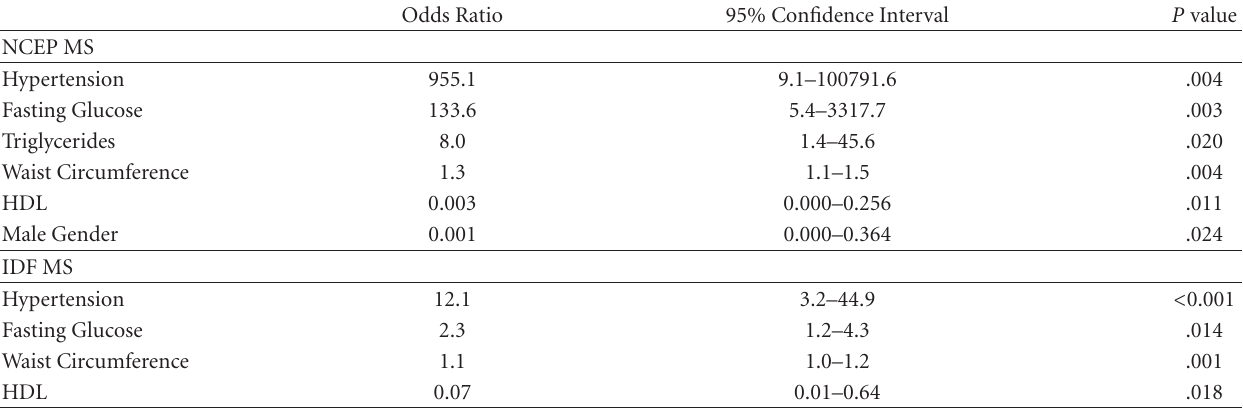
Table 4: Multivariate predictors of metabolic